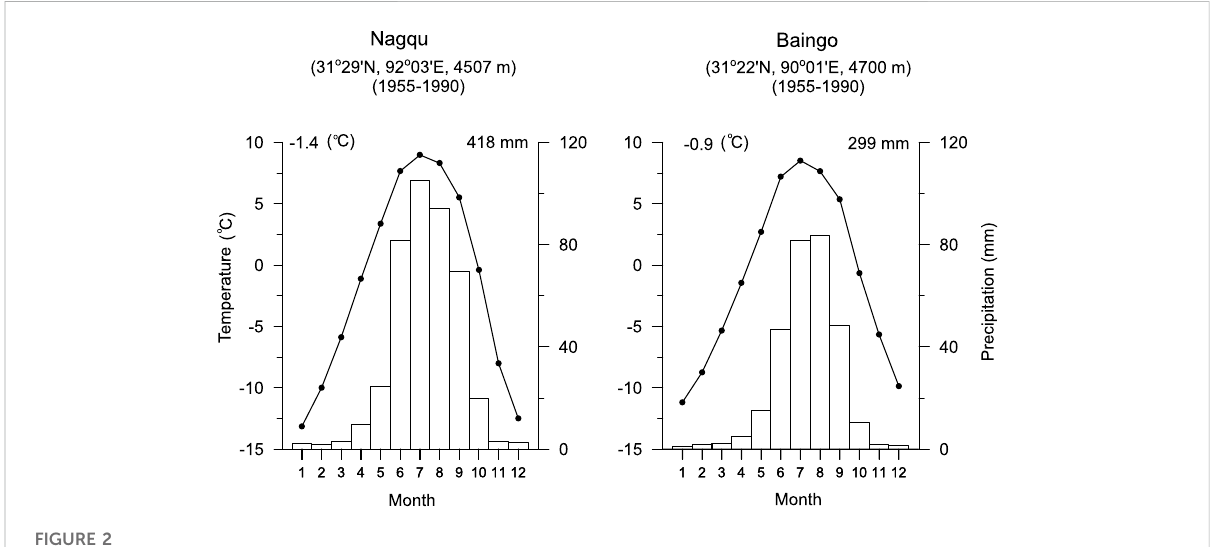
FIGURE 2 Summary of regional climate; lines are temperature and bars are